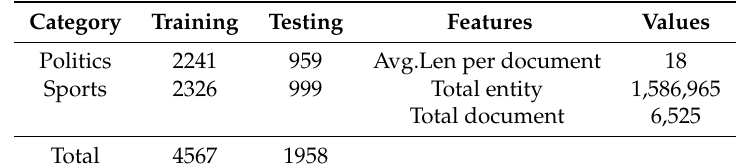
Table 2. The Twitter data set.